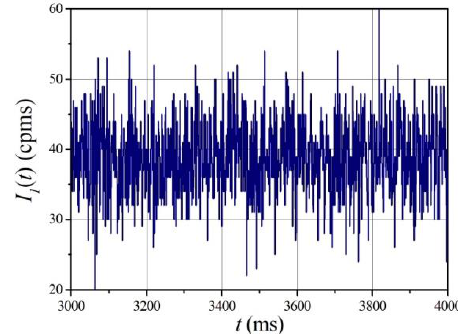
Fig. 3. The part of signal for the analyzed